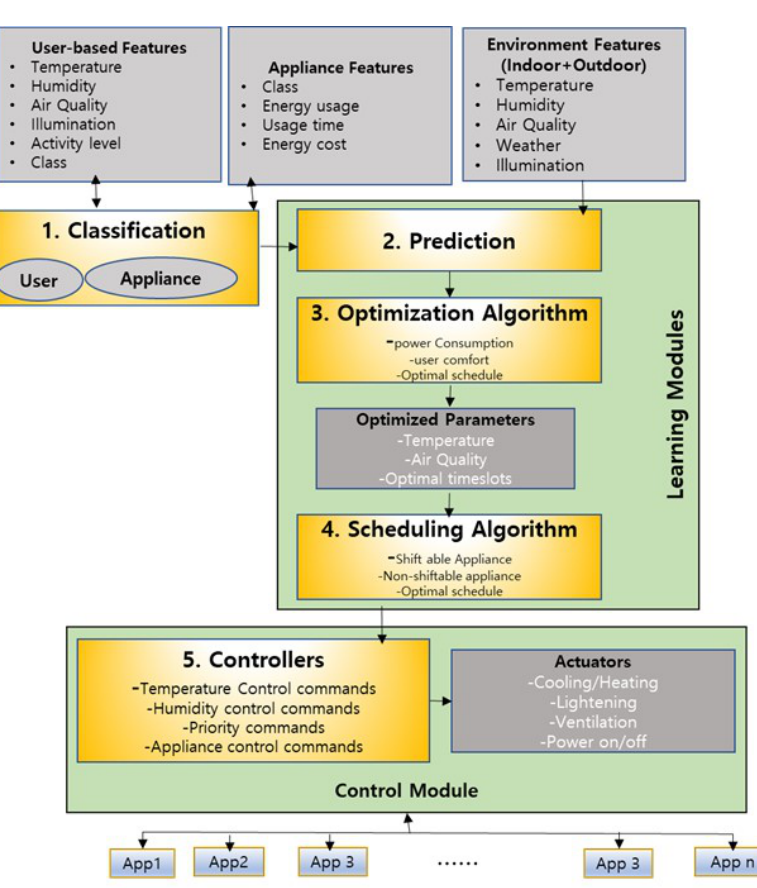
Figure 1. Conceptual view of the proposed